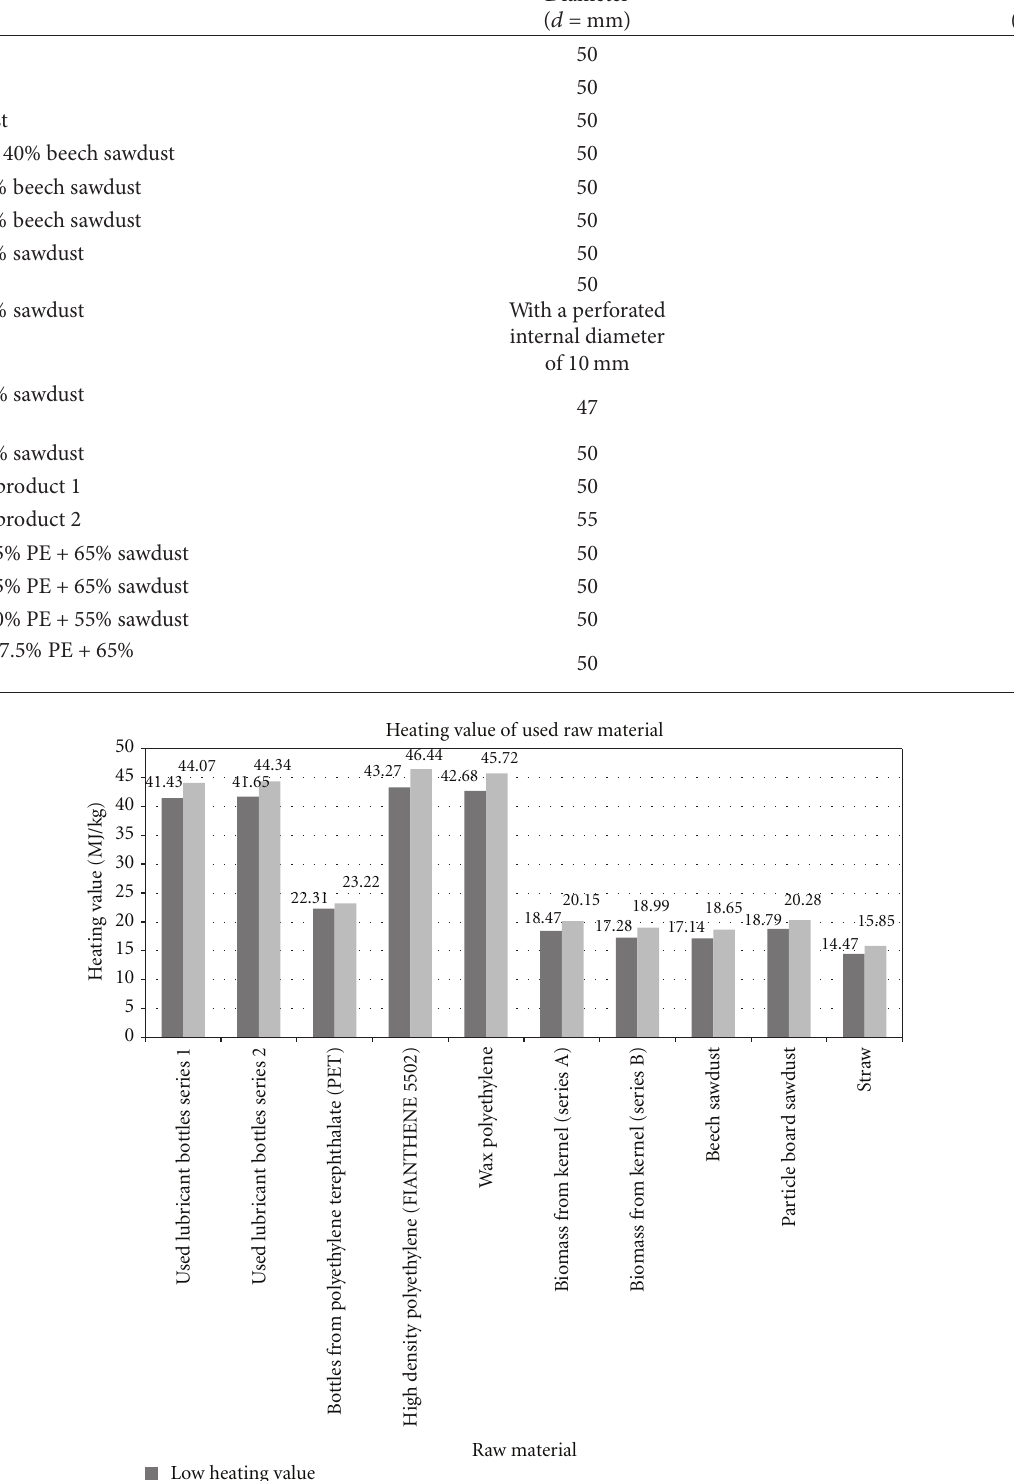
T 3: Geometrical characteristics of the manufactured briquettes. Briquette